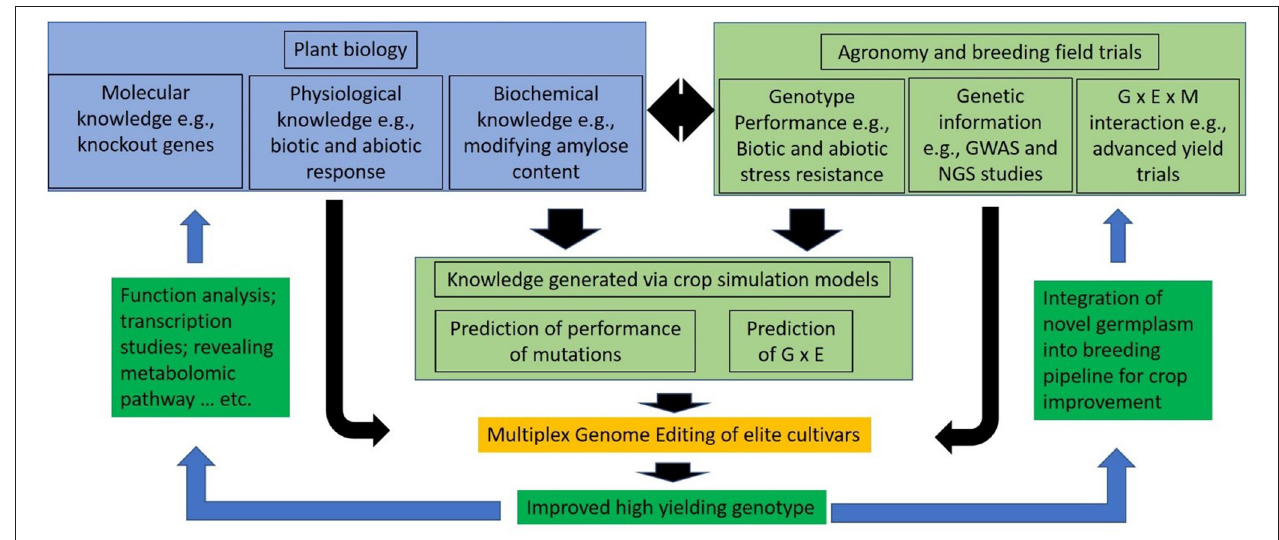
FIGURE 2 | The role of multiplex genome editing (MGE) is explained: the development of novel germplasm is accelerated that either increases knowledge in plant biology or assists crop improvement programs.